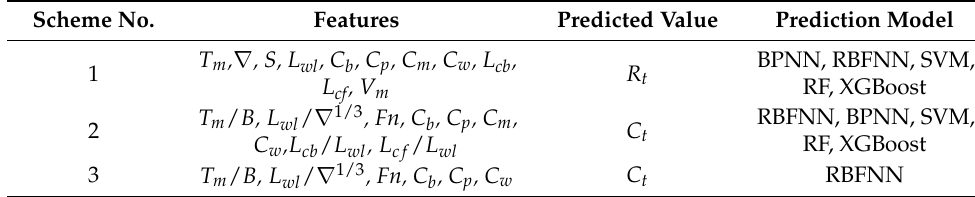
Table 6. Ship features and predicted value schemes. Scheme